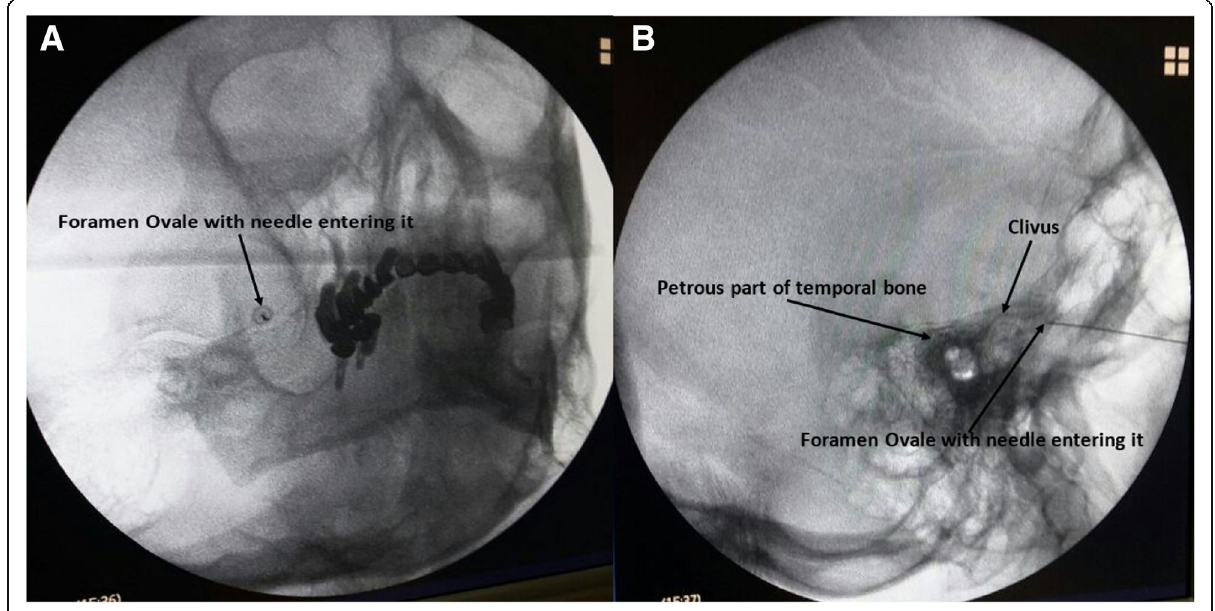
Fig. 1 a Submental view of the foramen ovale and b lateral view to confirm the depth of the needle